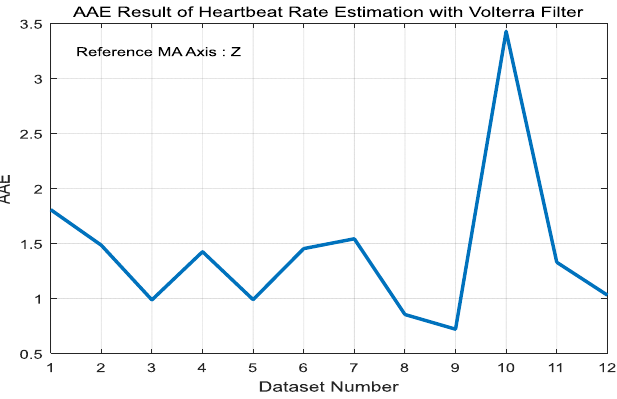
Figure 8. AAE’s of the Volterra filter of dataset 2 for each